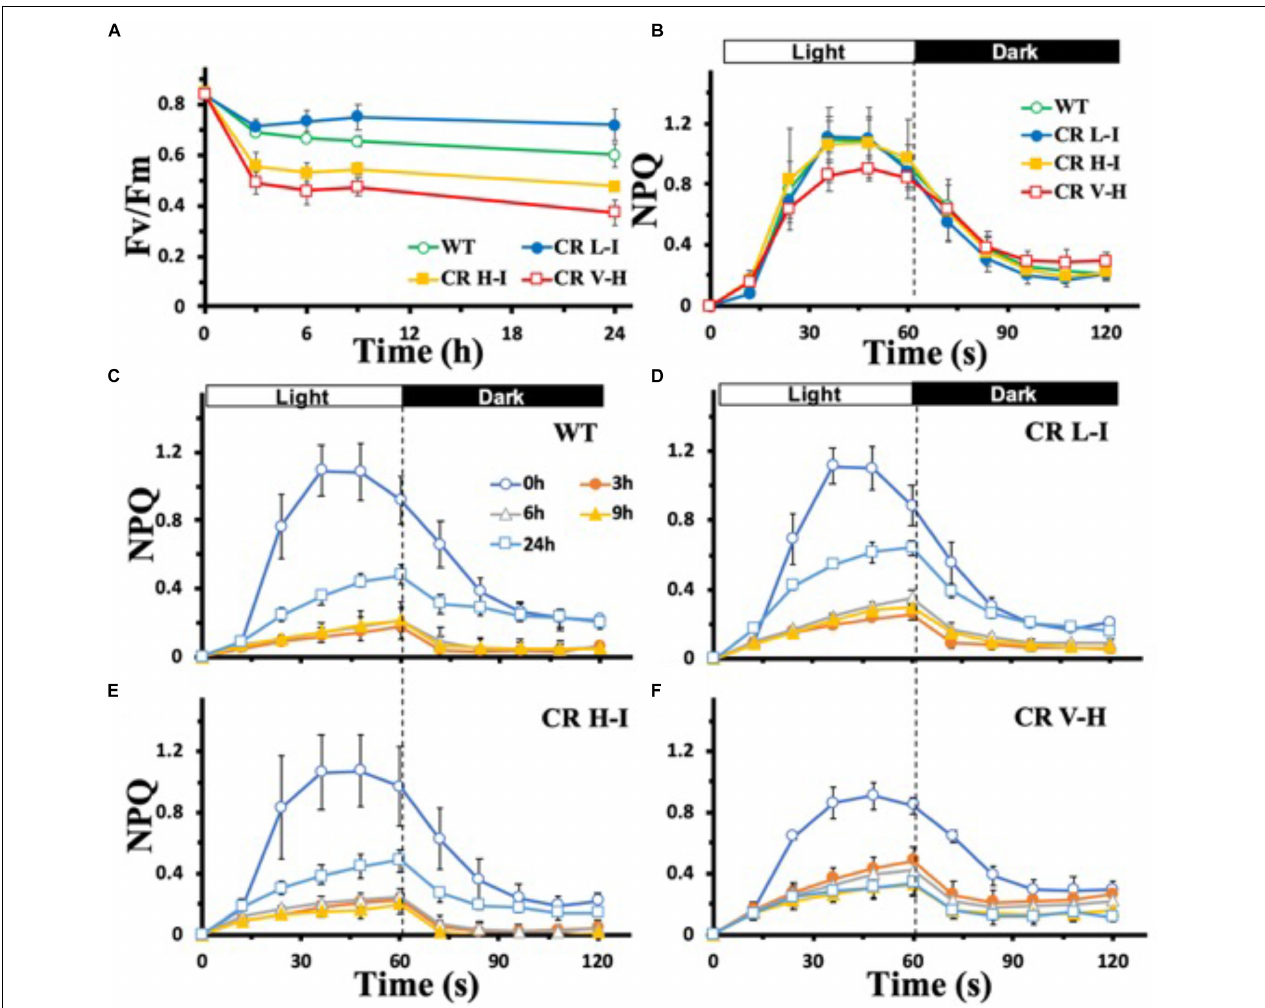
FIGURE 1 | Comparison of Fv/Fm and NPQ development and relaxation kinetics in wild-type and CAO RNAi transgenic lines under high light stress. Wild-type (WT), CR L-I (Chl a/b = 4.5–6.5), CR H-I (Chl a/b = 6.5–8.5), and CR V-H (Chl a/b 8.5 or above) plant leaves were dark-adapted for 30 min before the measurement of Fv/Fm (A) and NPQ (B–F) . Leaves were exposed to high light (HL) stress at 1,000 µ mol photons m − 2 s − 1 for 24 h. For the measurement of NPQ development and relaxation kinetics, leaves were exposed to actinic light (100 mmol photons m − 2 s − 1 ) for 60 s and were then kept in darkness for 60 s. The effects of HL stress on the NPQ development and relaxation kinetics were tested for 24 h in WT (C) , CR L-I (D) , CR H-I (E) , and CR V-H (F) lines. All experiments were done using fully expanded leaves from the top of 4–5 weeks old plants. Results represent the average and SD of three independent measurements.